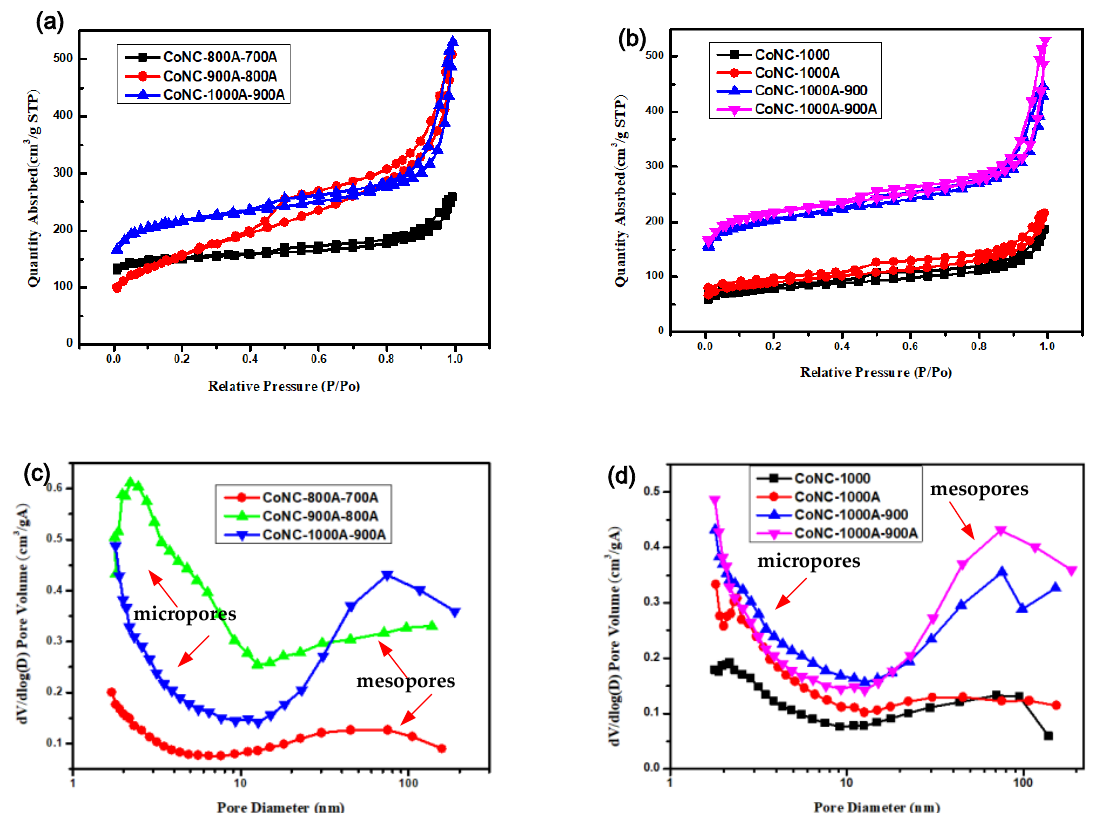
Figure 5. ( a , b ) N 2 adsorption–desorption isotherms and ( c , d ) pore size distribution of Co-N-C catalysts treated with different methods of calcination.